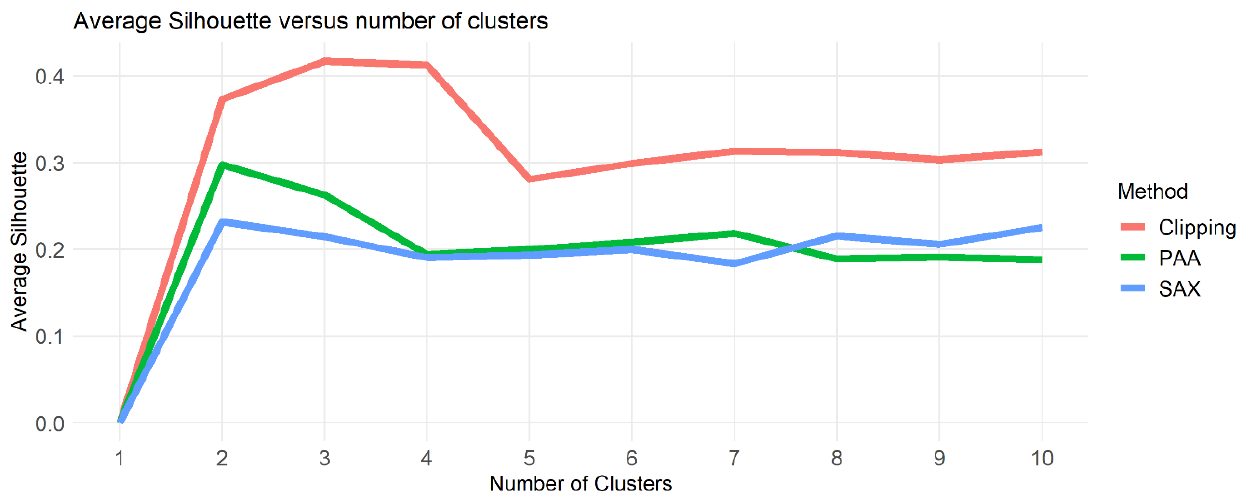
Figure 9. Second clustering phase average silhouette versus number of clusters per technique.